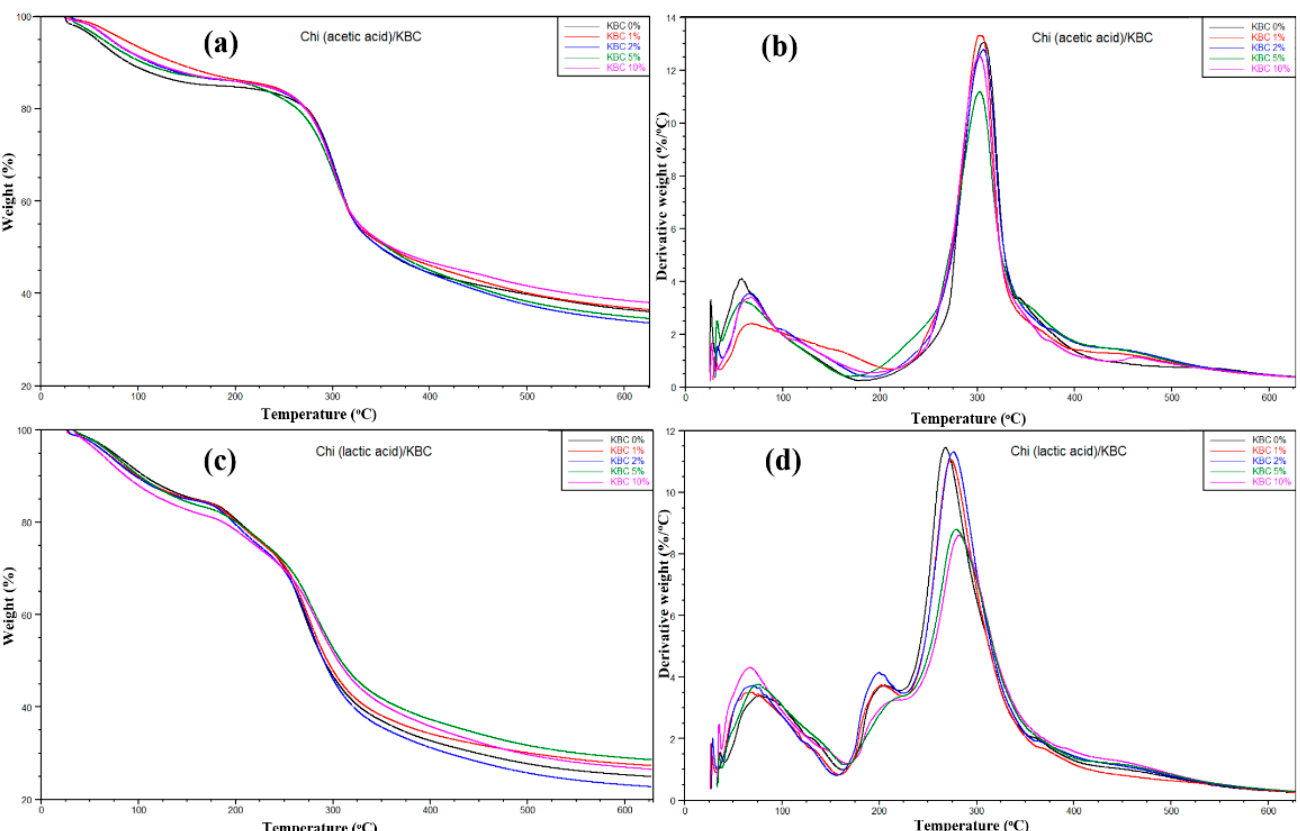
Figure 4. Plots of ( a , c ) TGA and ( b , d ) DTG of prepared films (Chi (acetic and lactic acid)/KBC) at various concentrations of